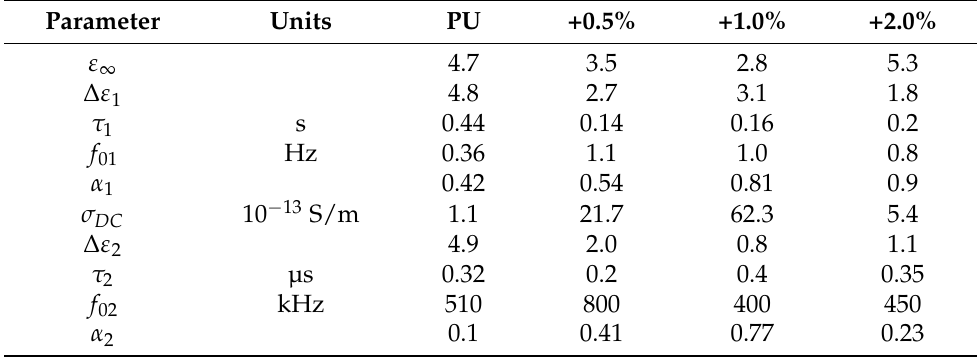
Table 3. Parameters obtained from the fit by the Cole-Cole model for PU and its various nanocom- posites at temperatures 80 °C, where ε ∞ is the high-frequency limit of the permittivity, σ DC is the DC conductivity, τ is the relaxation time, f 0 = 1/(2 πτ ) and α is the shape